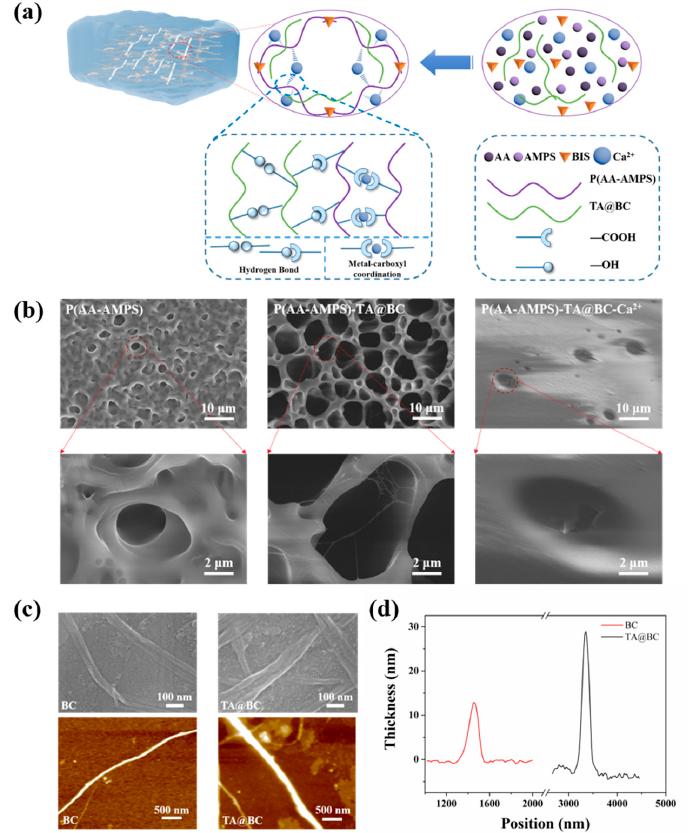
Figure 1. ( a ) Schematic diagram of hydrogel structure. ( b ) SEM images of P(AA ‐ AMPS), P(AA ‐ ( a ) Schematic diagram of hydrogel structure. ( b ) SEM images of P(AA-AMPS), AMPS) ‐ TA@BC, P(AA ‐ AMPS) ‐ TA@BC ‐ Ca 2+ hydrogel. ( c ) AFM images of BC and TA@BC P(AA-AMPS)-TA@BC, P(AA-AMPS)-TA@BC-Ca 2+ hydrogel. ( c ) AFM images of BC and TA@BC cellulose. ( d ) Thickness distribution curve of BC and TA@BC in AFM. cellulose. ( d ) Thickness distribution curve of BC and TA@BC in